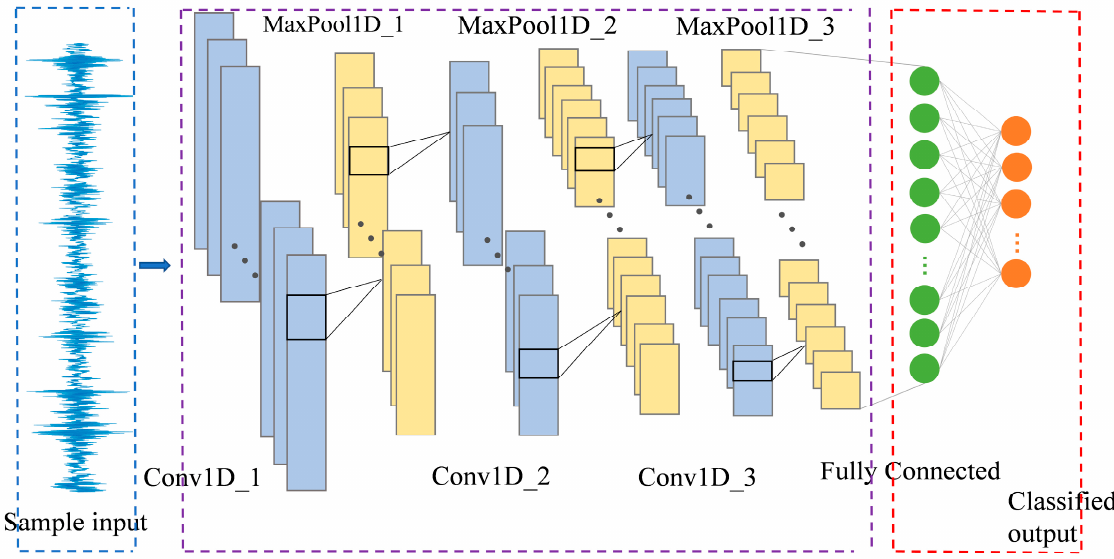
Figure 1. The 1D-CNN structure Figure 1. The 1D ‐ CNN structure diagram.